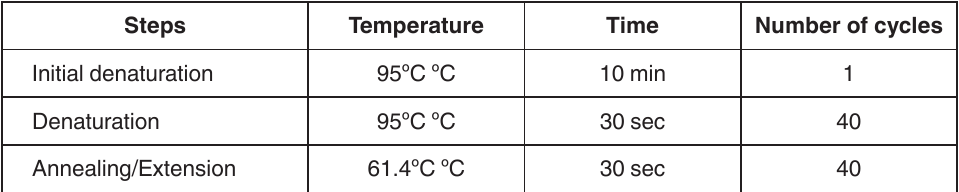
Table 3. Amplification cycle for Campylobacter foetus subsp. venerealis used for real-time PcR